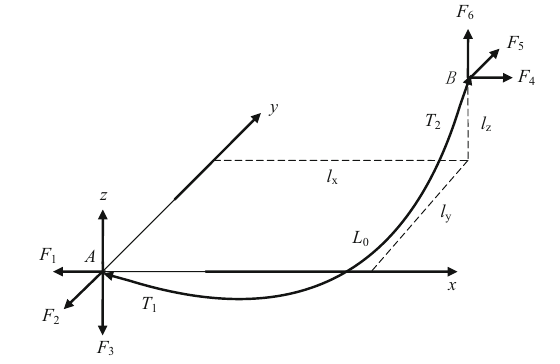
Fig. 5 Flexible cable element